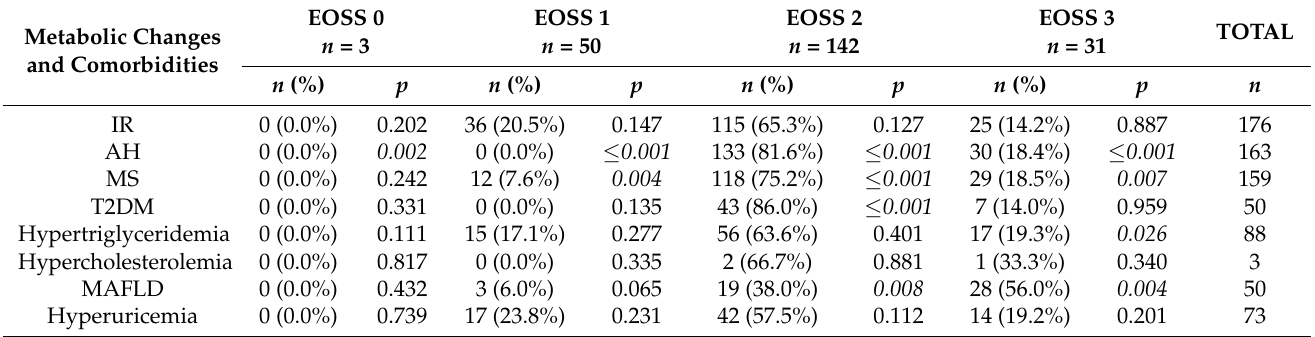
Table 1. Percentage of incidence of metabolic changes and comorbidities present in the sample according to the stages of the Edmonton Obesity Staging System